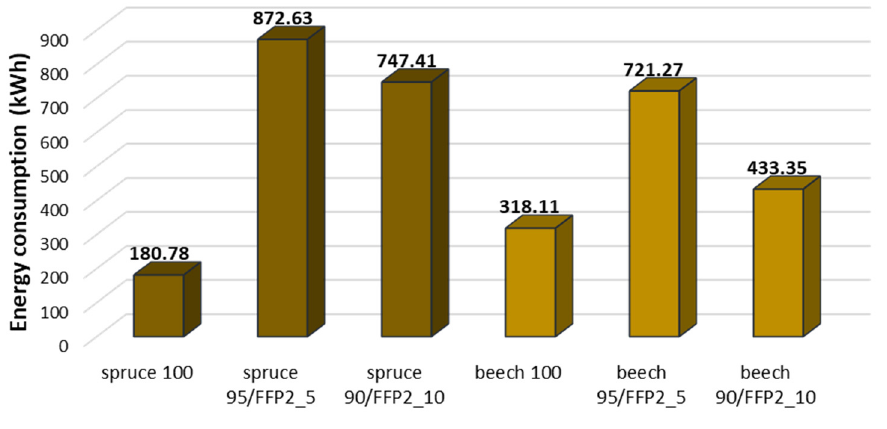
Figure 4. Energy consumption.